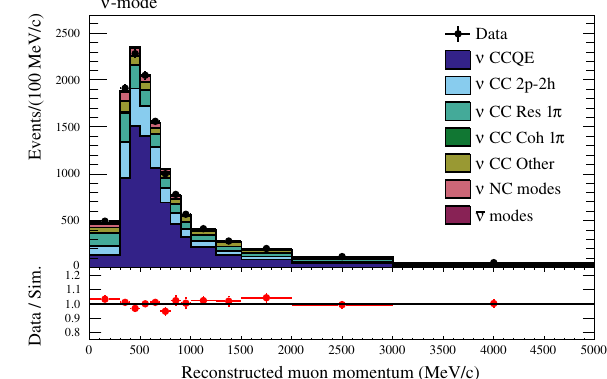
Fig. 60 Muon momentum distributions of the neutrino beam mode CC-0 π samples in FGD1 [62]. The dots are data, and the histograms are the predictions by simulation before flux+cross section tuning is applied (Pre-fit). The ratio of data to the prediction is shown in the bottom plot